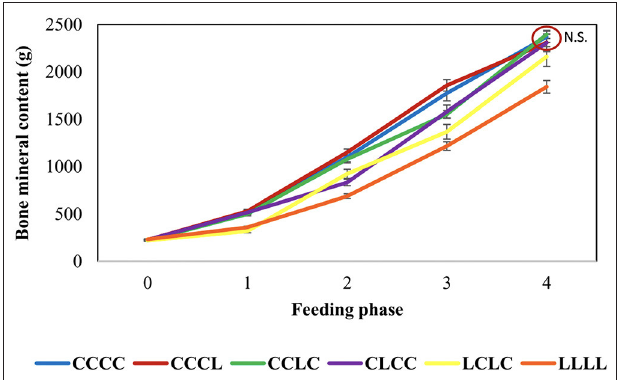
FIGURE 8 | Body bone mineral content of growing pigs feeding depletion–repletion diets (145).